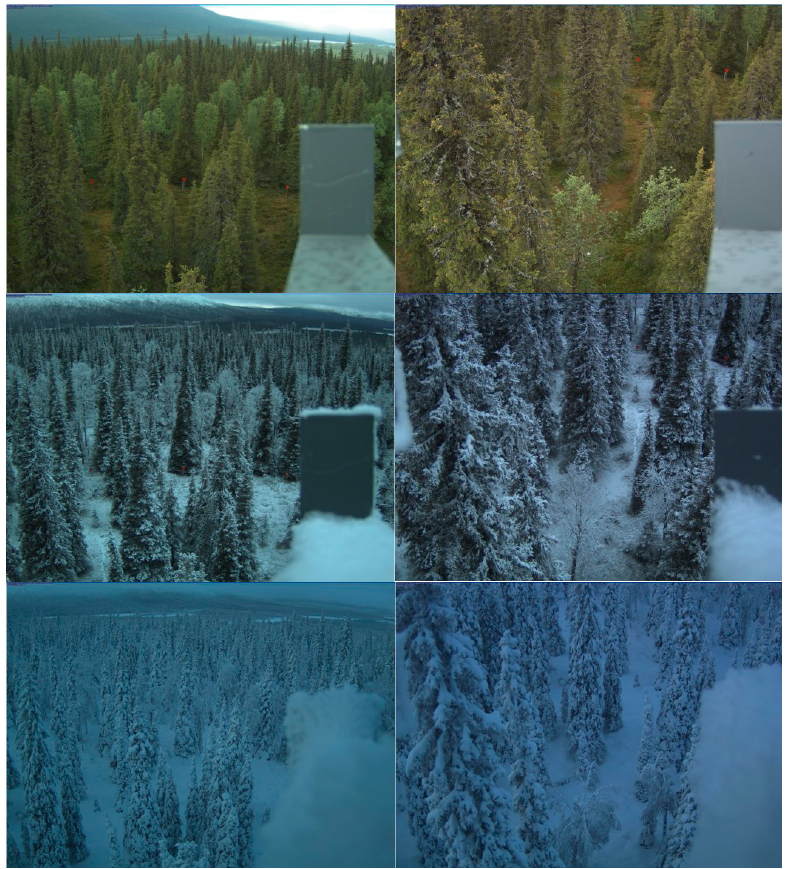
Figure 1. Example images from canopy ( left panels ) and ground cameras ( right panels ) of Kenttärova on 18 June 2016, 12:00 ( top ), 3 November 2016, 09:30 ( center ) and 25 November 2016, 11:00 ( bottom ).